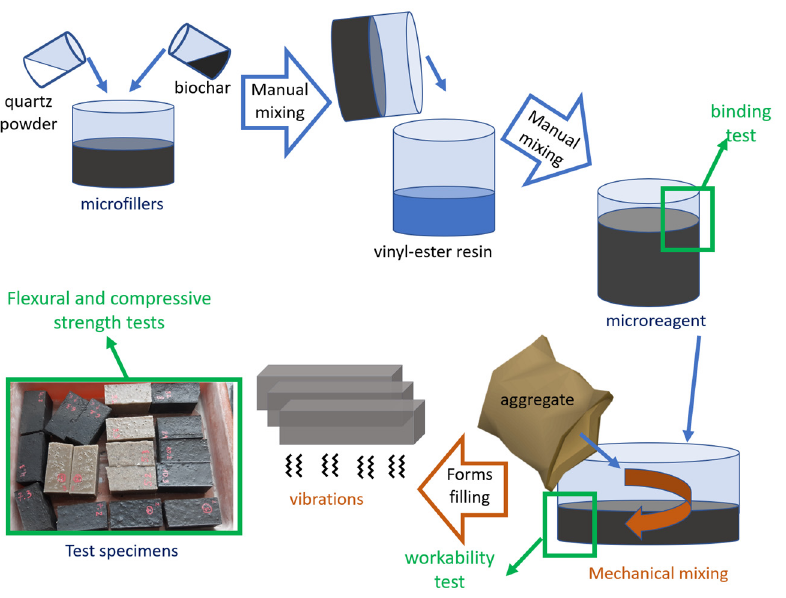
Figure 3. Manufacturing